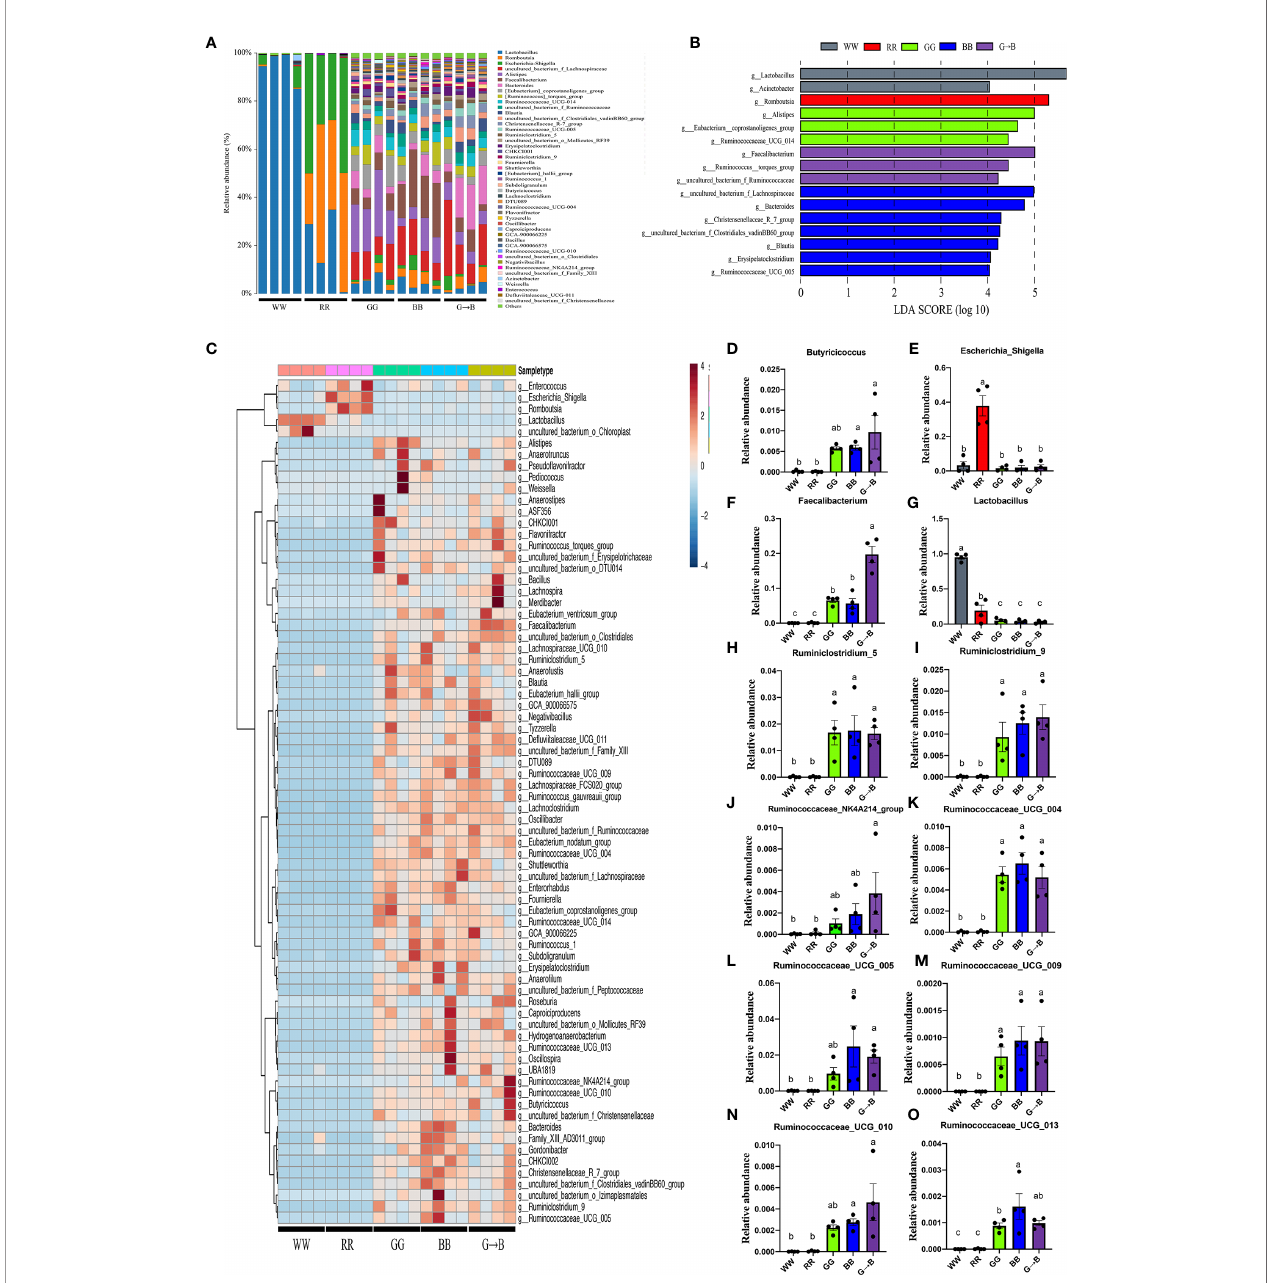
FIGURE 4 | Forty- fi ve genera that were present at a relative abundance of >0.1% in the cecum microbe of the WW, RR, GG, BB, and G ! B groups were identi fi ed (A) , linear discriminant analysis effect size approach identifying the different genera in the chick cecum microbe of the WW, RR, GG, BB, and G ! B groups at P42 (B) . Heat map of the redundancy analysis identifying the most differentially abundant genus in cecum microbiota in response to different monochromatic light combinations (C) . Taxonomic pro fi les of the notably signi fi cantly different bacteria at the genus level in the chick cecum of WW, RR, GG, BB, and G ! B groups at P42 (D – O) . WW, white light; RR, red light; GG, green light; BB, blue light; G ! B, green light and blue light combination. The results are presented as means ± SEM. Different letters indicate signi fi cant differences between the treatments at the same age ( P <